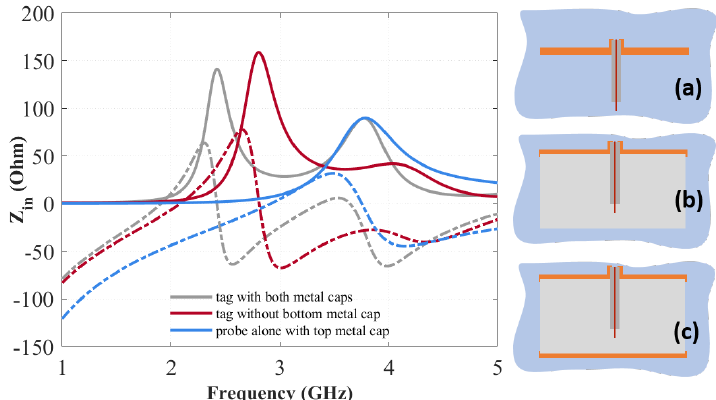
Figure 3. Real (continuous) and imaginary (dashed) part of the input impedance as a function of frequency considering the probe alone placed on the top metal cap ( a ), the dielectric structure without the metal bottom cap ( b ) and with both metal caps ( c ).